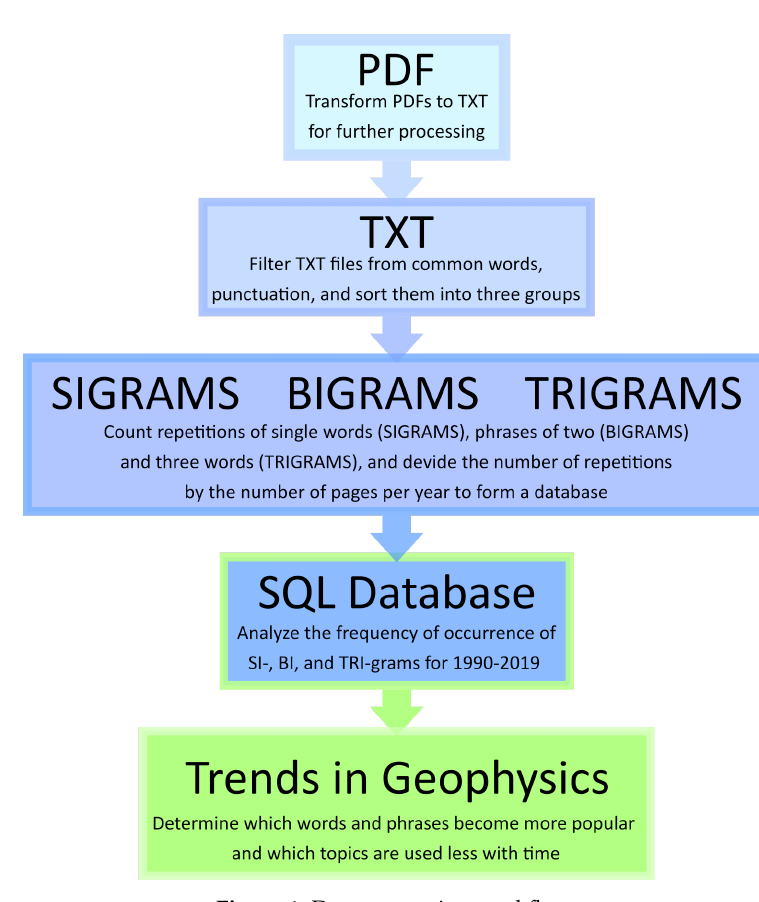
Figure 1. Data processing